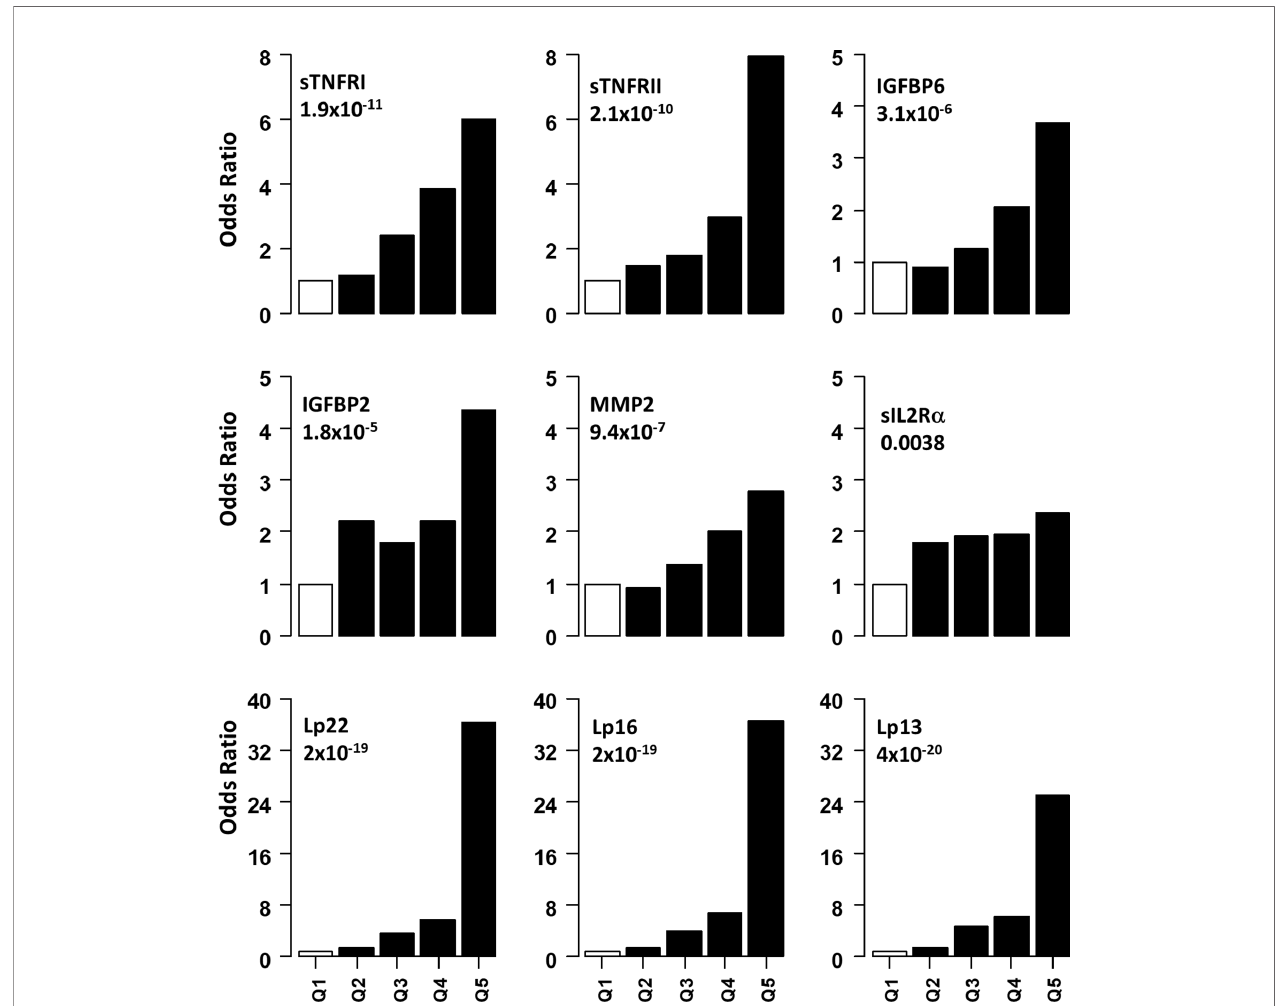
FIGURE 2 | Association of serum level of proteins with presence of DPN. Odds ratios associated with each of the top four quintiles compared to the bottom 1 st quintile for each of the twelve individual proteins. The open bar represents the 1 st quintile as reference (OR = 1). From left to right, each of the other four solid bars represents the 2 nd to 5 th quintile (20% of the DPN patients). Odds ratios associated with the risk scores calculated based on different combinations of 22 (Lp22), 16, (Lp), 13(Lp) and 11 (Lp) proteins using ridge regression. Vertical axes are odds